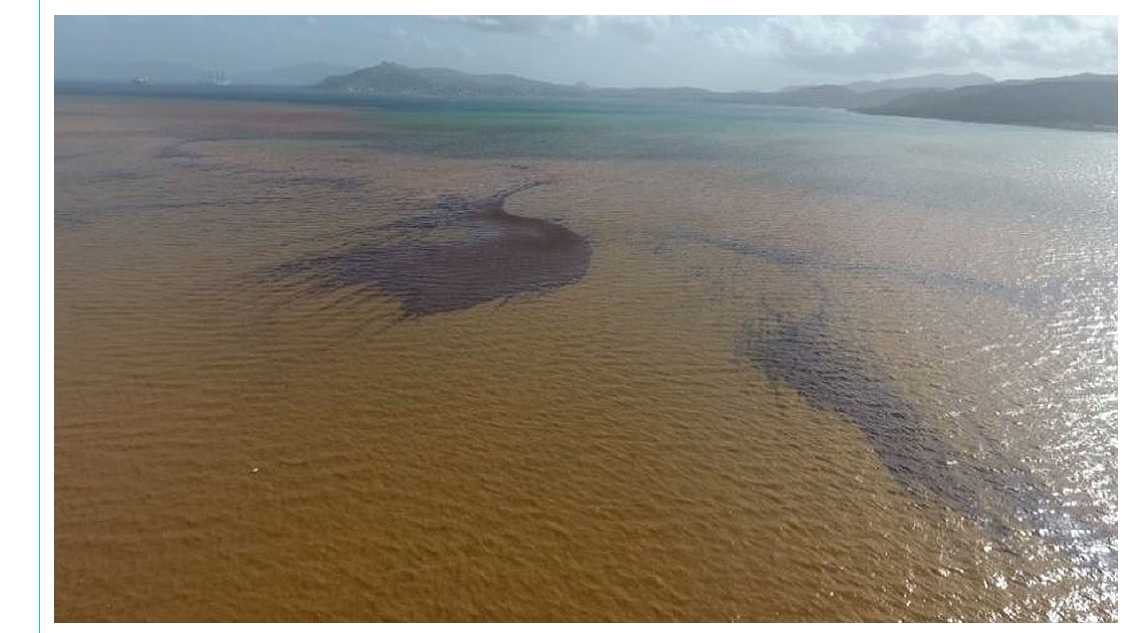
Figure 4: Searching for pollution in the bay of west Athens after the floods of Mandra (2017). From reference